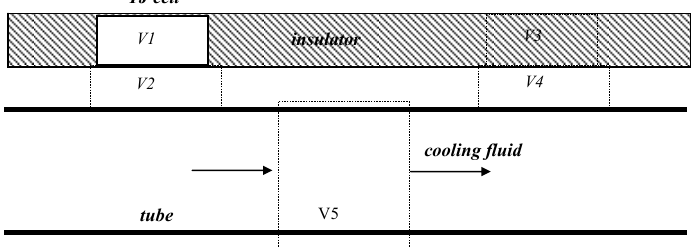
Figure 4. Control volumes.